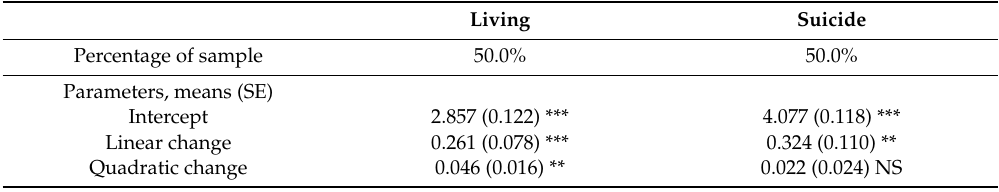
Table 1. Trajectory